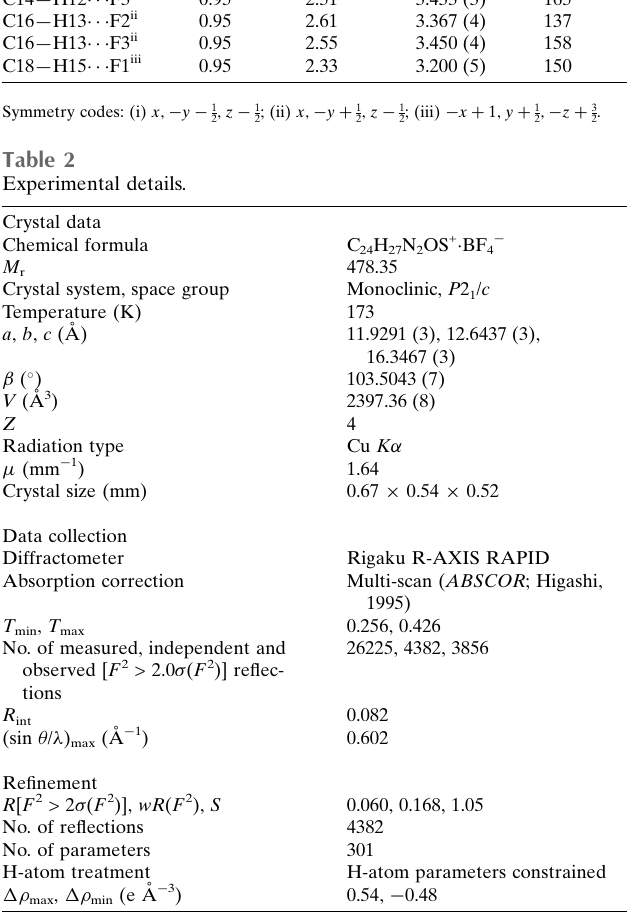
(Table 1), forming a three-dimensional network (Fig. 2).